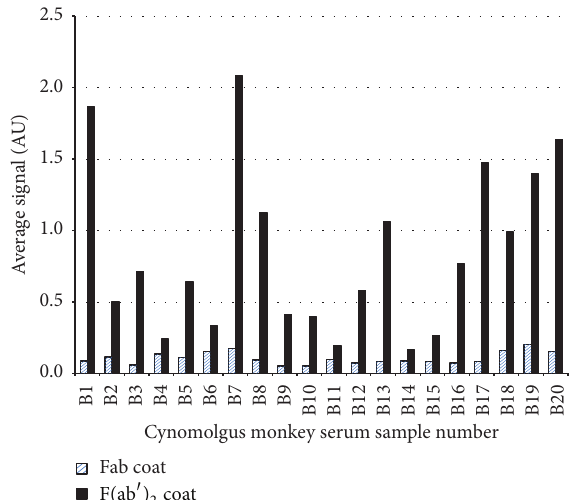
Figure 3: Comparative reactivity of cynomolgus monkey serum samples with anti-DLL4 Fab or anti-DLL4 F(ab 󸀠 ) 2 directly coated on a well (direct binding format). More sample reactivity is observed with the F(ab 󸀠 ) 2 coat.